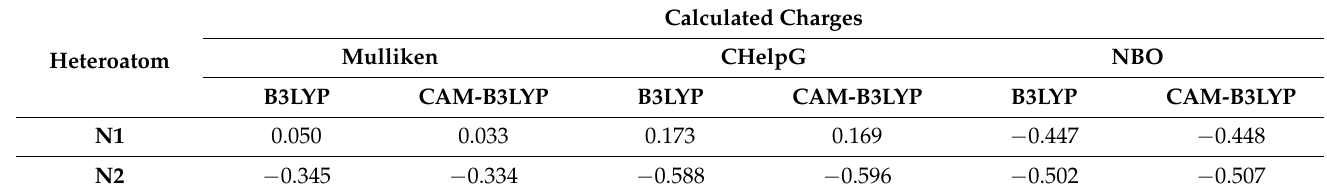
Table 2. The atomic charges [ e ] for nitrogen atoms within the structure of bifonazole (geometry optimized at the B3LYP/6-31G(d,p) or CAM-B3LYP/6-31G(d,p) levels of theory in gaseous phase, the Mulliken, CHelpG and NBO charges computations at the B3LYP/6-311++G(2d,3p) or CAM-B3LYP/6- 311++G(2d,3p) levels of theory) estimated according to the Mulliken, CHelpG or NBO methodology (atoms numbering as in the Figure 1).